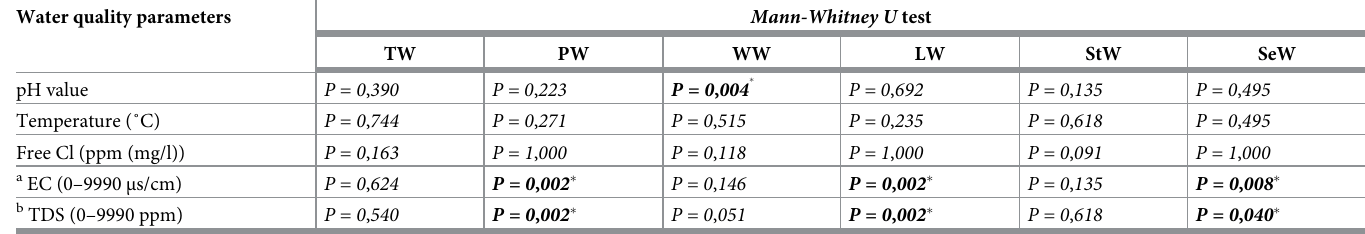
Table 6. Result of non-parametric test showing the relationship between five different water quality parameters and the presence/absence of Acanthamoeba spp. in various water sources. Water quality